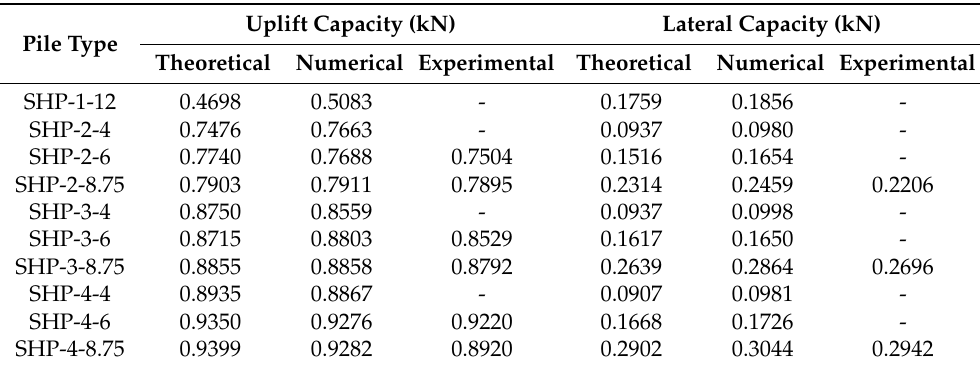
Table 3. Theoretical, numerical, and experimental results of uplift and lateral